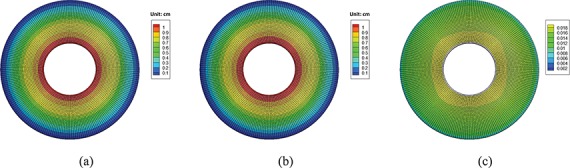
Normed displacement plot from (a) IB/FE and (b) ABAQUS. (c) The relative difference (only showing the regions below 2\documentclass[12pt]{minimal}
\usepackage{amsmath}
\usepackage{wasysym}
\usepackage{amsfonts}
\usepackage{amssymb}
\usepackage{amsbsy}
\usepackage{upgreek}
\usepackage{mathrsfs}
\setlength{\oddsidemargin}{-69pt}
\begin{document}
}{}$\%$\end{document}).